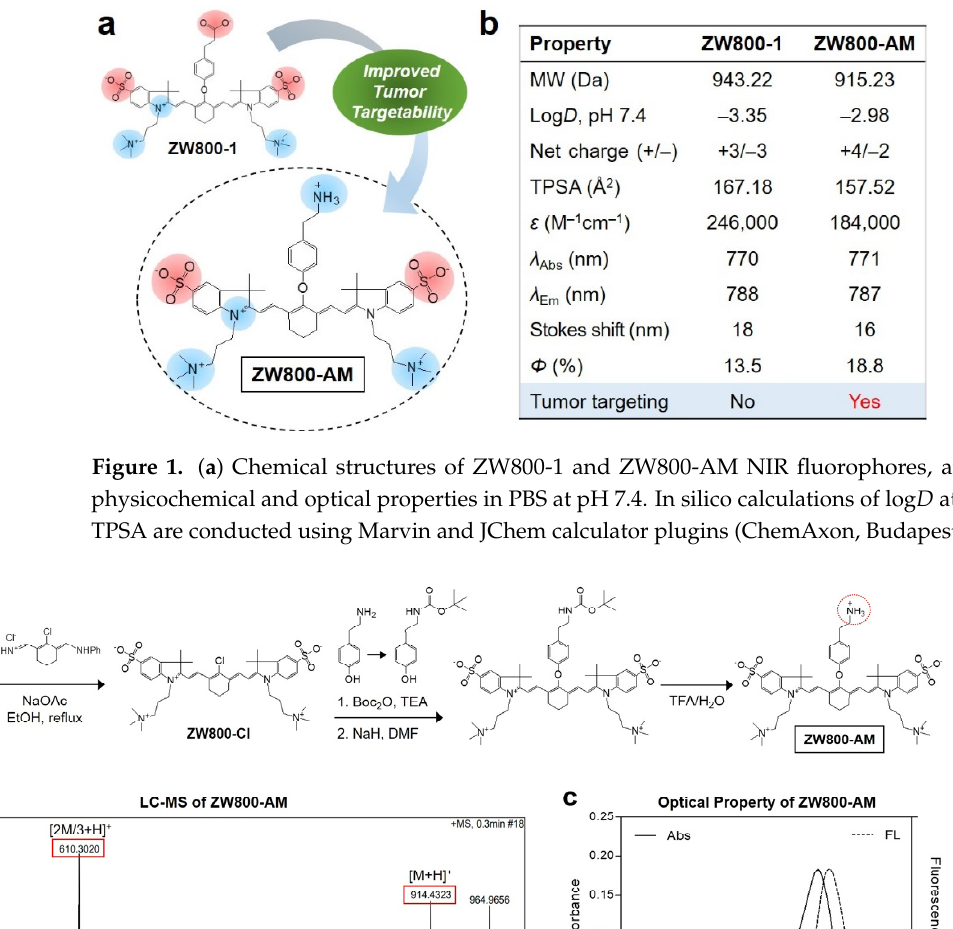
Figure 2. ( a ) Synthesis scheme, ( b ) mass spectrum, and ( c ) absorbance and fluorescence emission spectra of ZW800-AM NIR fluorophore. Optical measurements are performed in PBS at pH 7.4.